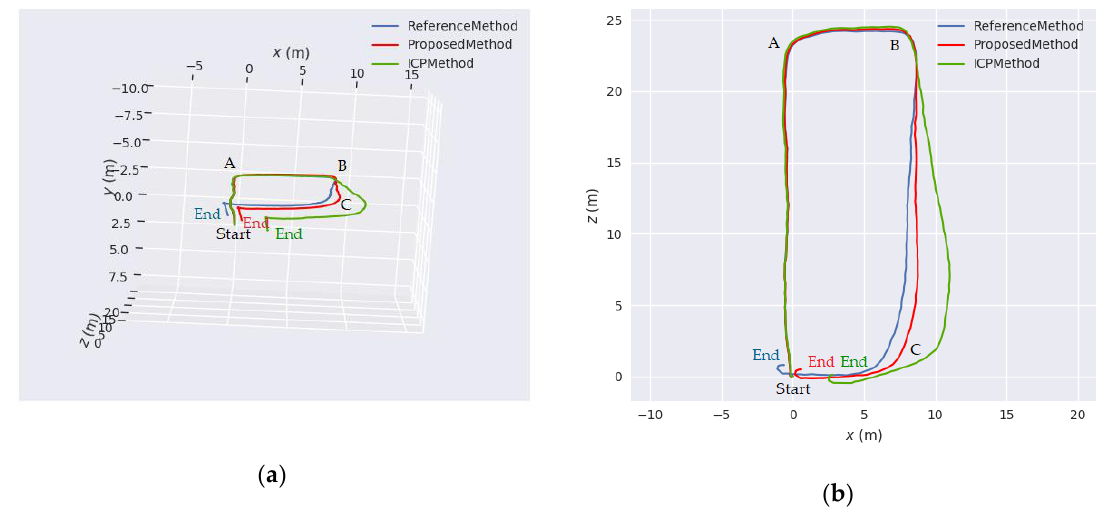
Figure 12. Estimated trajectories from the three methods. The blue curve represent the trajectory estimated using reference method. The red curve represent the trajectory estimated using our proposed method. The green curve represent the trajectory estimated using ICP method. ( a ) 3D display of the three trajectories; ( b ) Top view of the three trajectories.